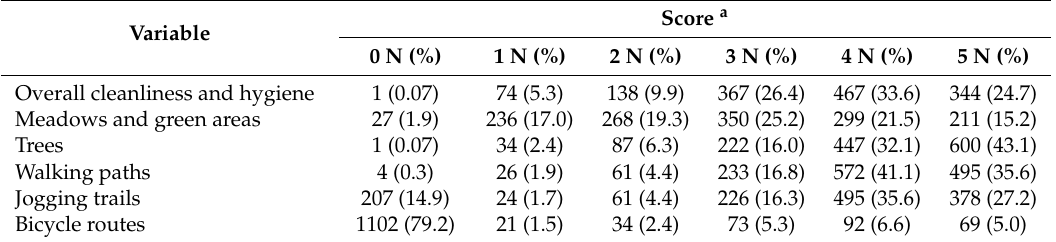
Table 3. Perceptions related with global condition of park infrastructure features (N =